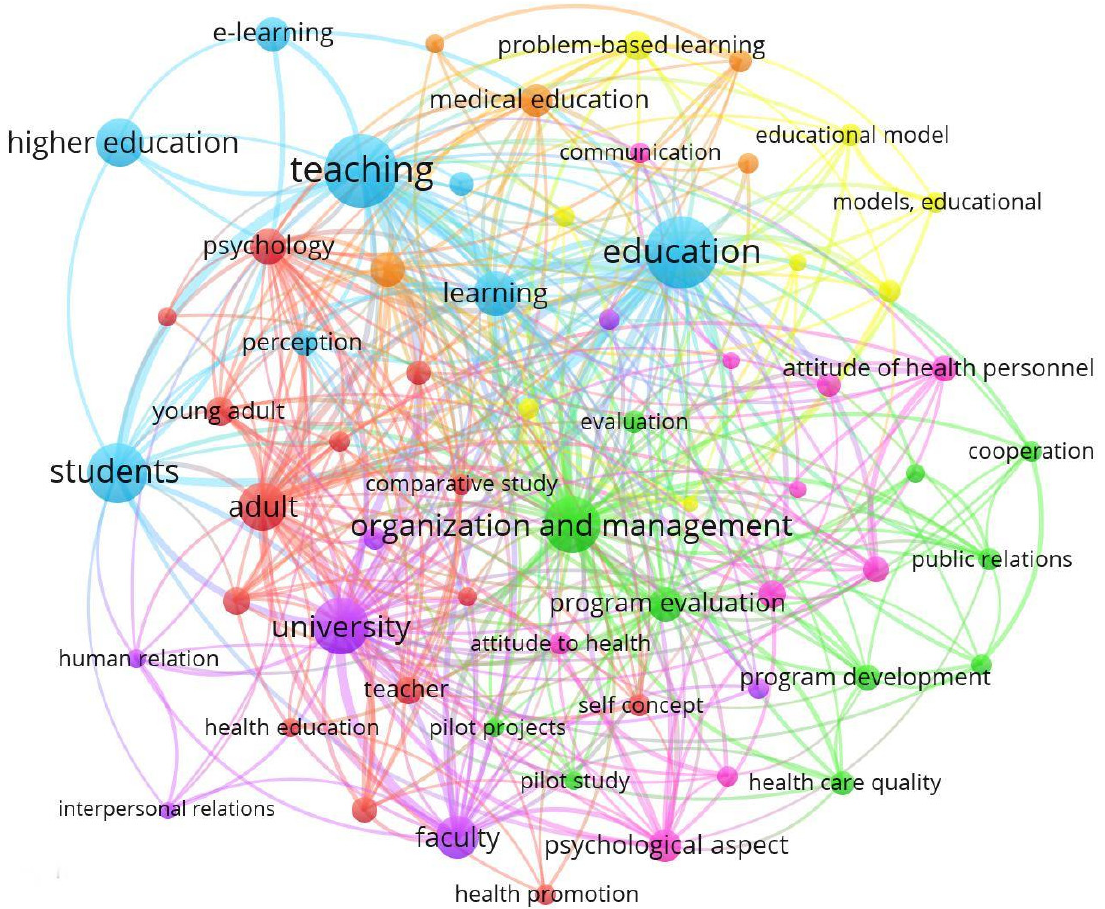
Figure 7. Keywords network based on co-ocurrence (2004–2018).